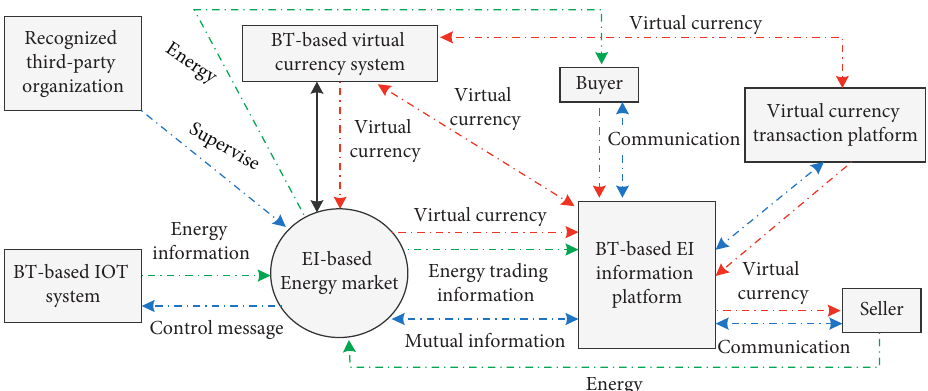
Figure 3: The schematic diagram of the BT-based virtual currency